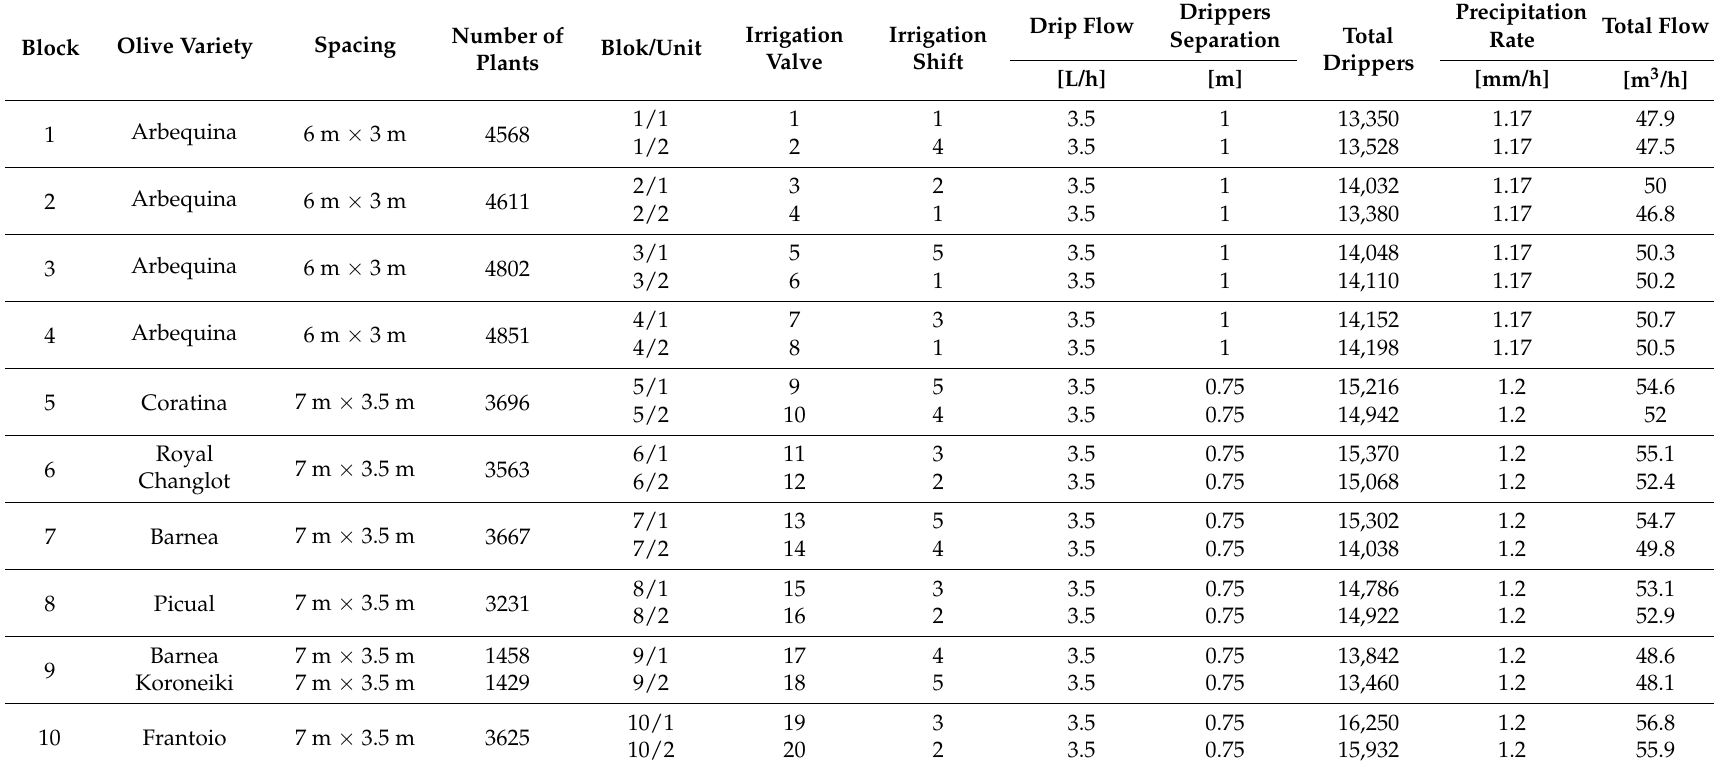
Table 1. Olive orchard and irrigation system